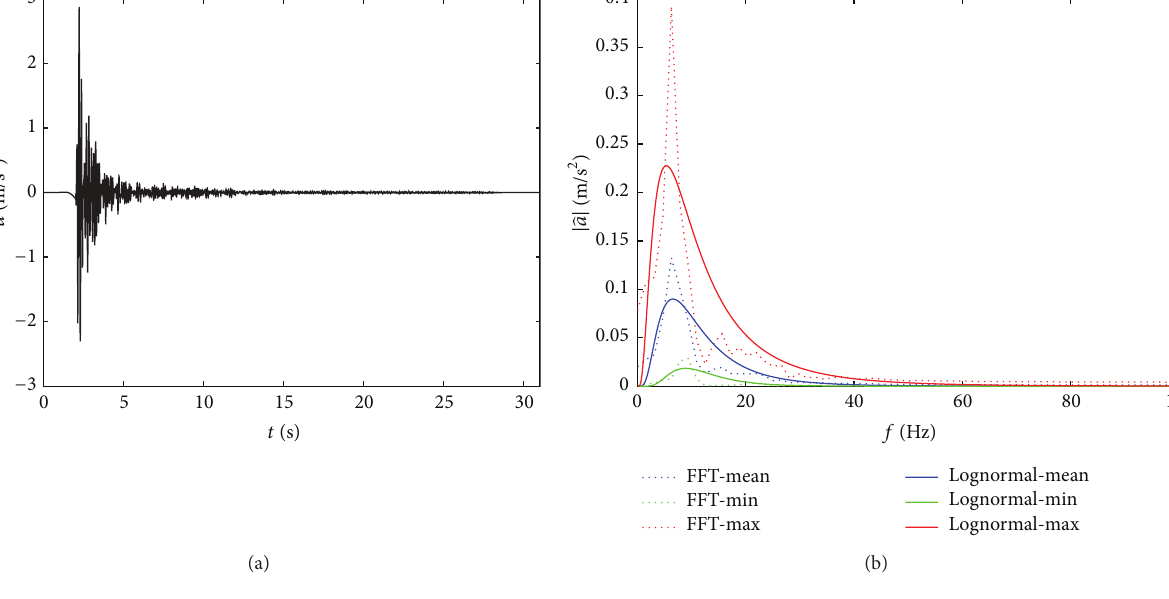
Figure 2: Seismic acceleration (a) and FFT absolute value (b).